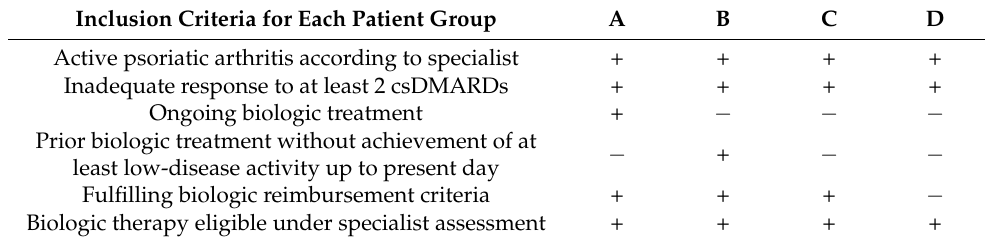
Table 1. Criteria for recruitment into clinical subgroups of